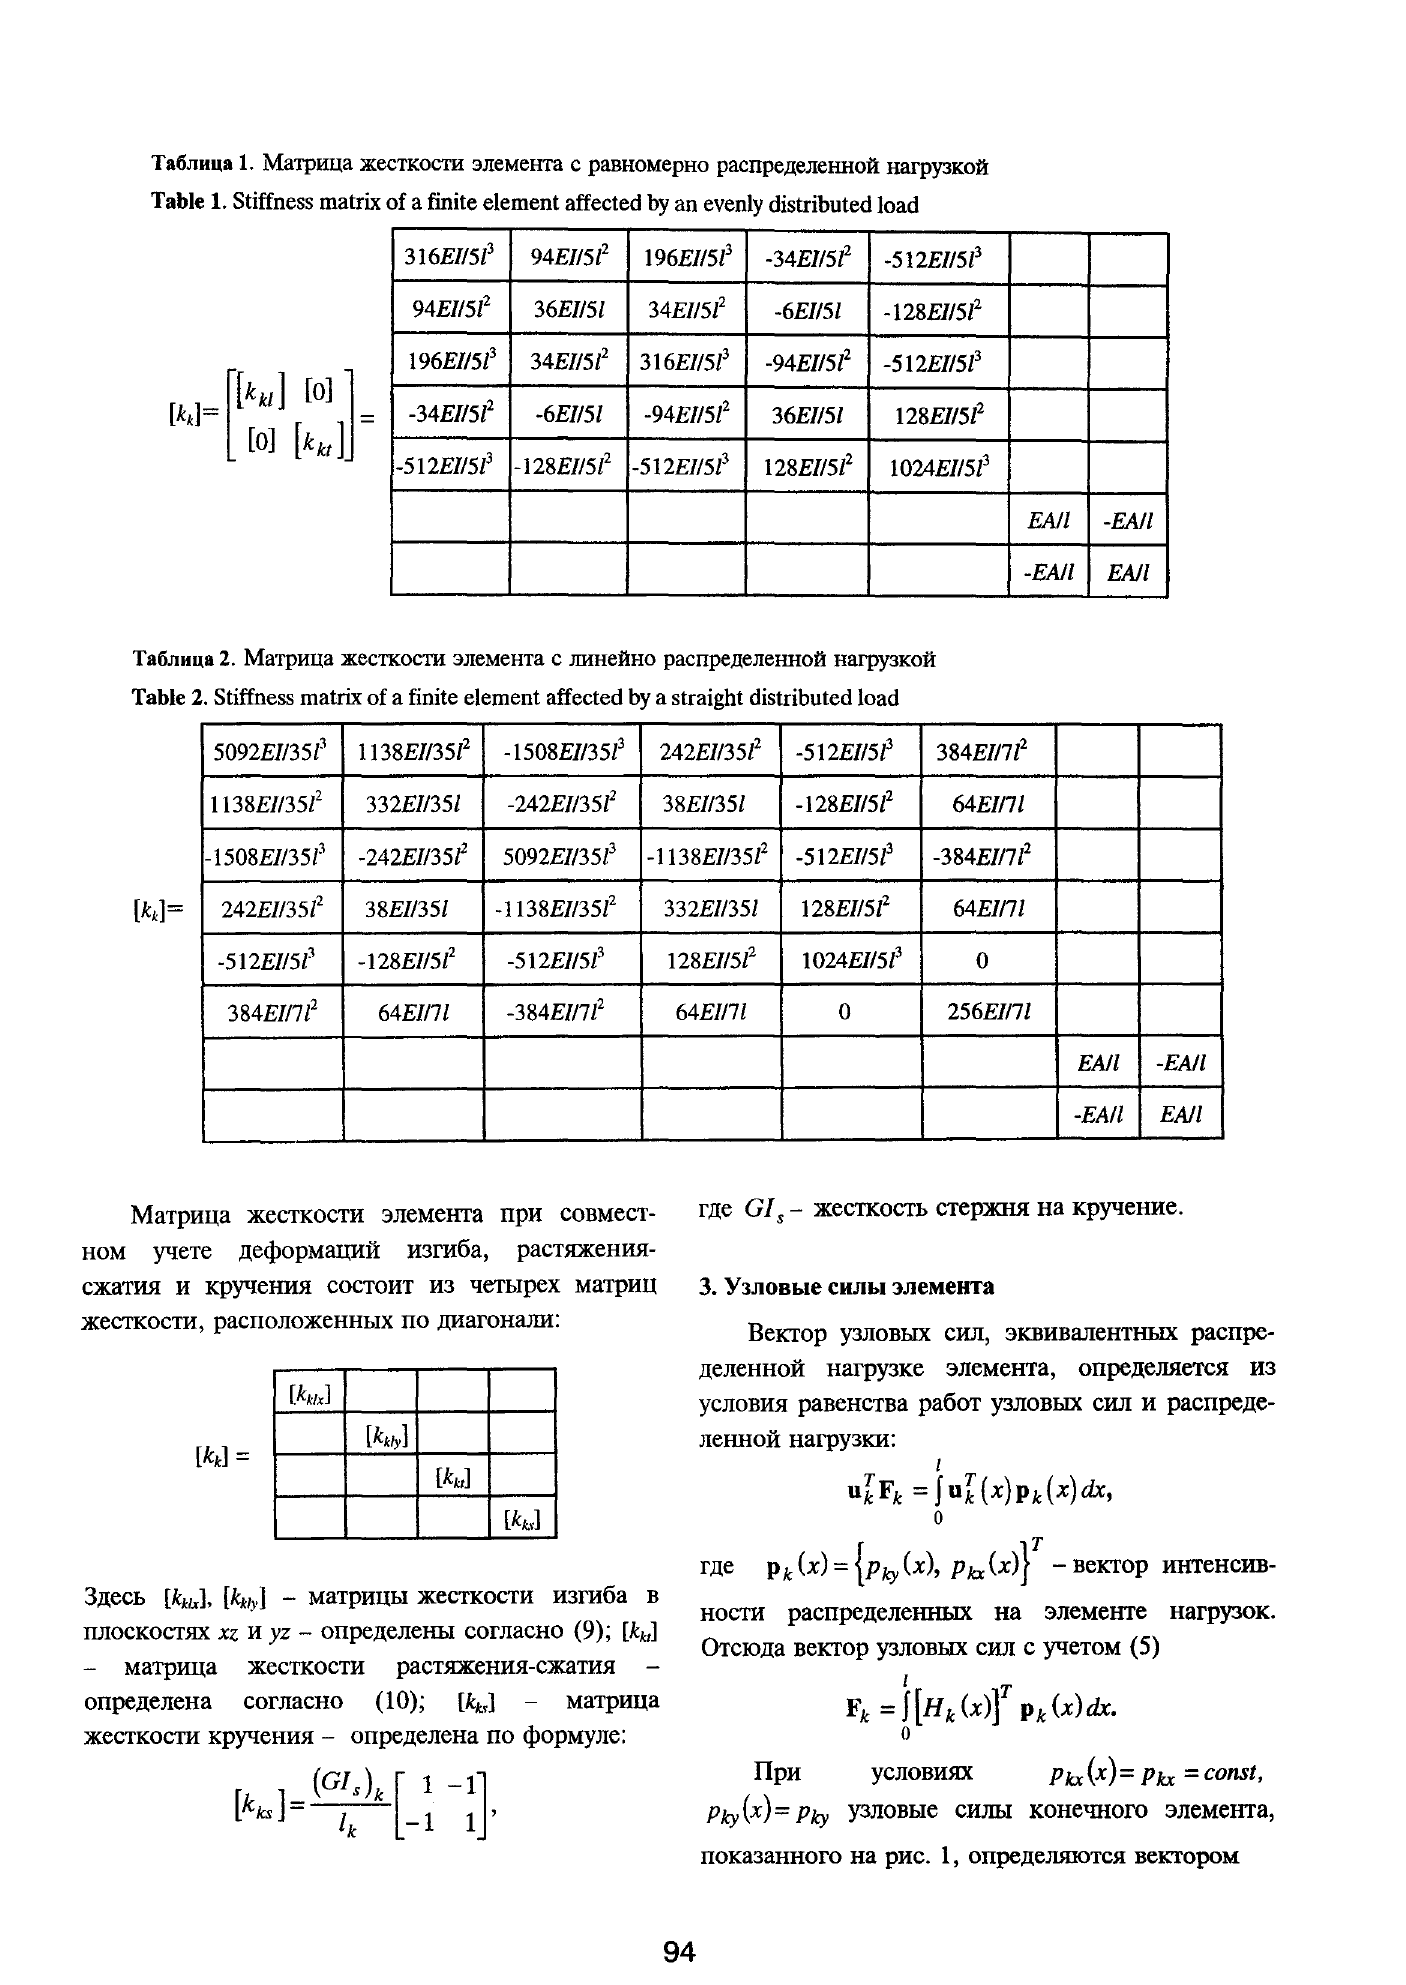
Table 1. Stiffness matrix of a finite element affected by an evenly distributed load